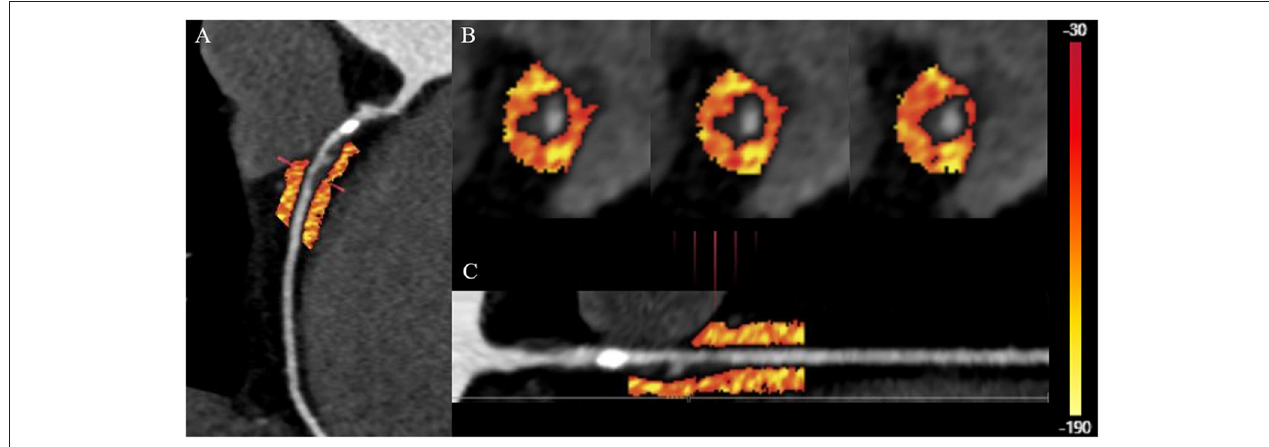
FIGURE 4 | Quantification of PCAT CT attenuation of low-attenuation plaques in the proximal-mid right coronary artery. (A) The multiplanar reconstructed image of PCAT measured with the range from − 190 to − 30 HU. (B) Cross-section images of PCAT measure. (C) Straightened image of PCAT measure. PCAT, pericoronary adipose tissue; HU, Hounsfield